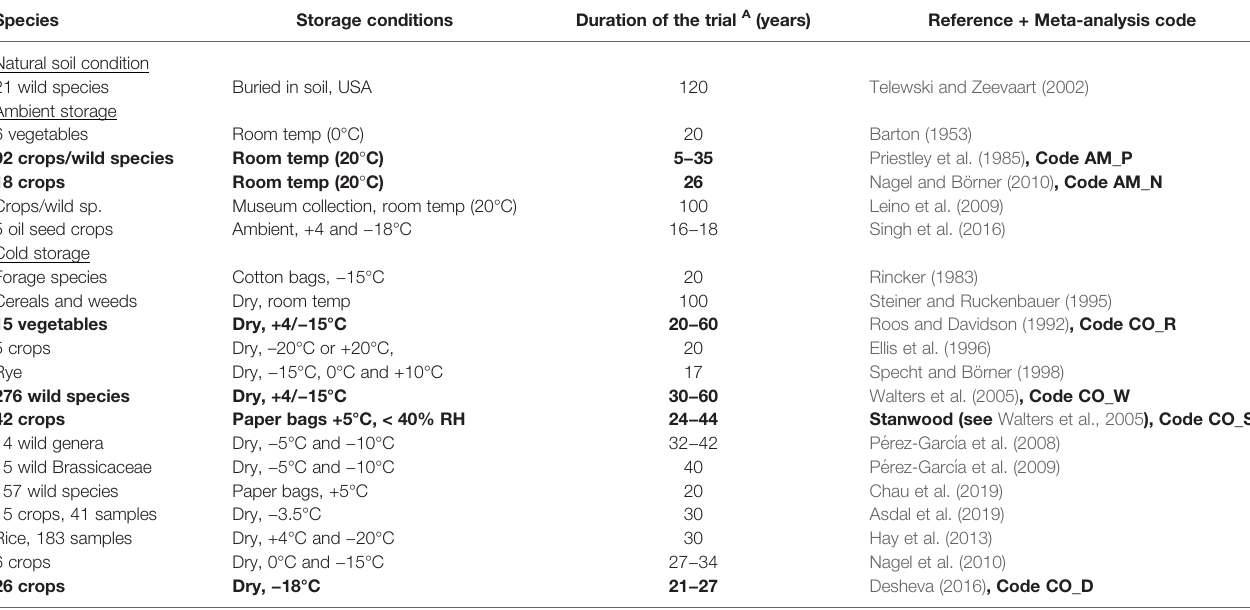
TABLE 1 | Overview of some important seed longevity trials with seeds stored under various conditions for a given